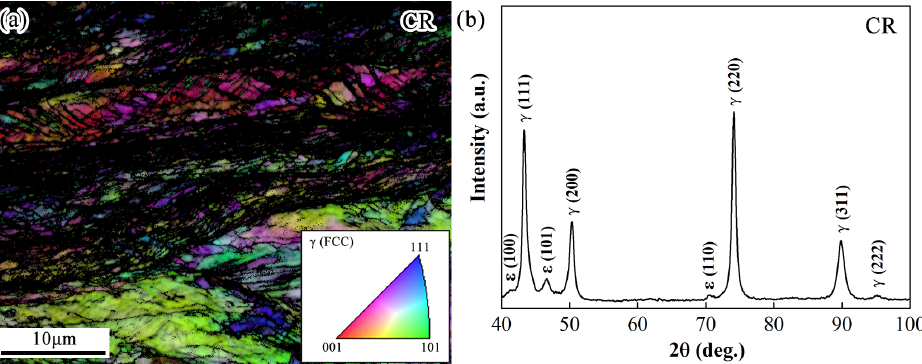
Figure 1. Microstructure of the CR specimen: ( a ) EBSD IPF + IQ map and ( b ) X-ray diffraction intensity profile.